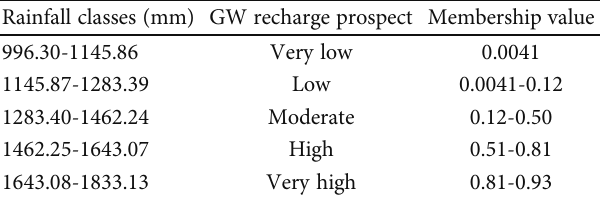
Table 3: Rainfall classes, membership value, and distribution. Rainfall classes (mm) GW recharge prospect Membership value